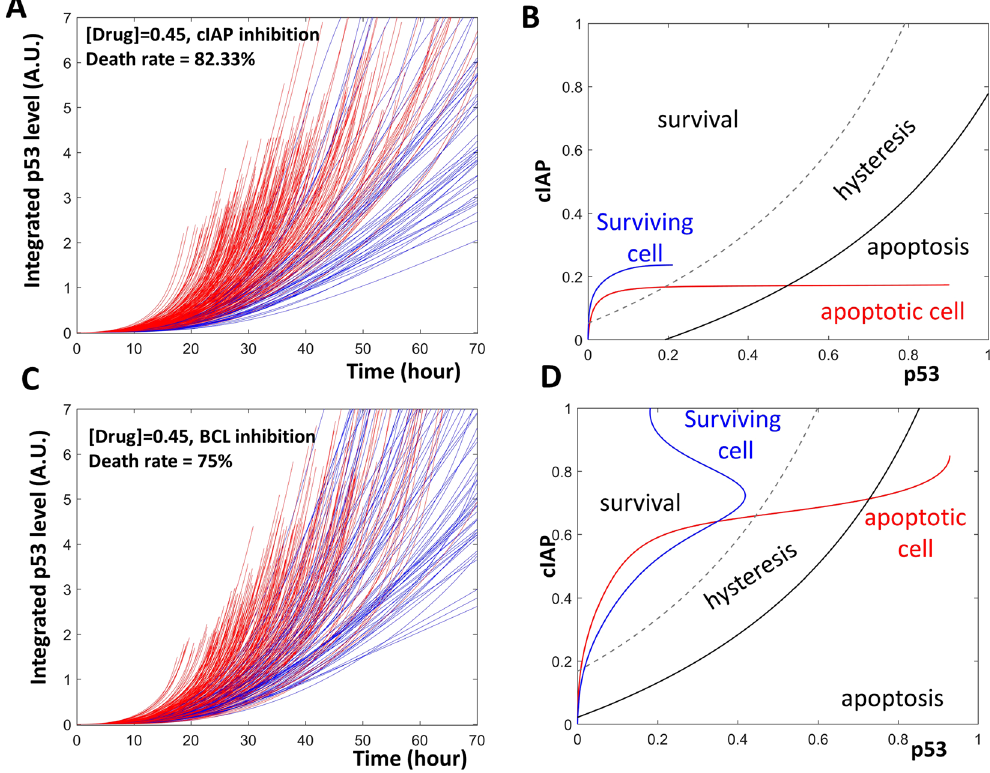
Figure 4. Two strategies against fractional killing. ( A ) Time series simulations of a population of cells that are treated with both cisplatin and a CIAP inhibitor. ( B ) Inhibition of CIAP changes the time dependent trajectories of an apoptotic cell (red curve) as well as a surviving cell (blue curve). ( C ) Time series simulations of a population of cells treated with cisplatin and a BCL inhibitor. ( D ) Inhibition of BCL expanded the area corresponding to